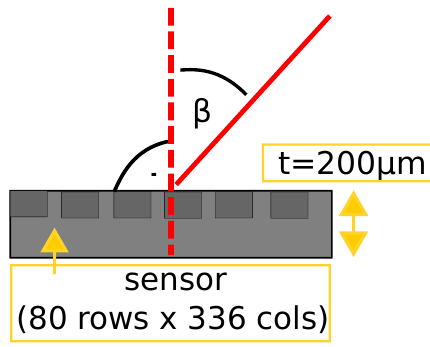
Figure 1. Sketch to define the incident angle β with respect to the normal of the detector surface. The thickness t of the sensor and the pixelation are